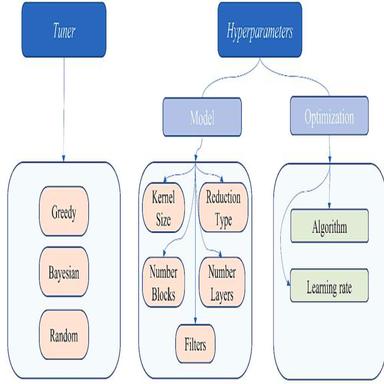
Convolutional neural network architecture search hyperparameter tree containing different optimization and model parameters.